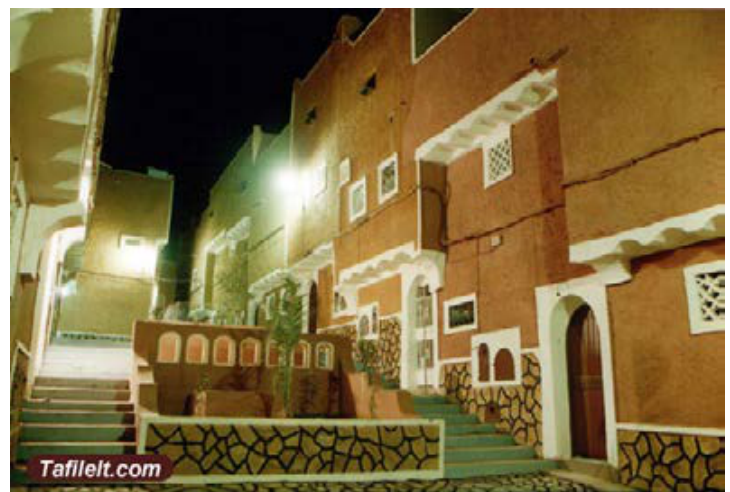
Figure 8. Adevelopment in harmony with the site